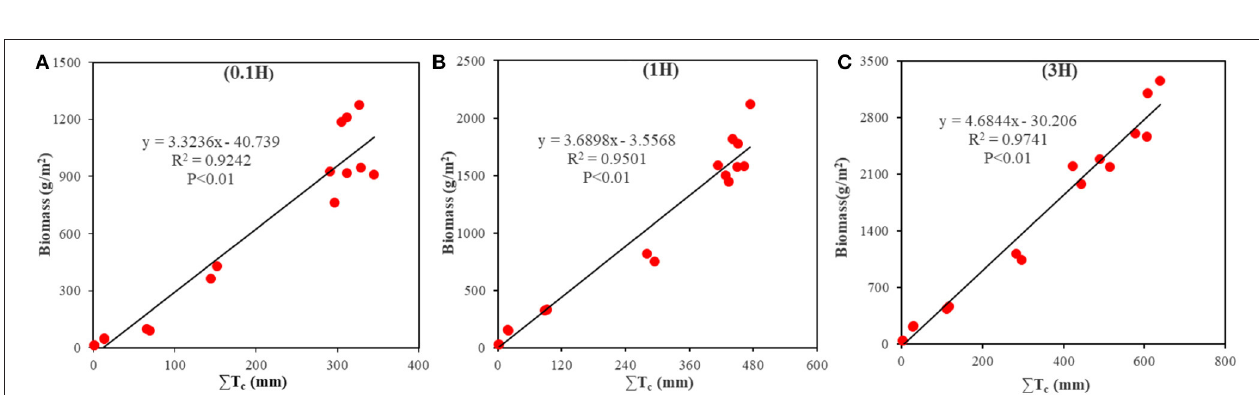
FIGURE 8 | Fitting results of measured biomass and actual transpiration (T c ) at the sampling points with different distances from the shelterbelt (0.1H, 1H, and 3H). (A) represents the fitting result within 0.1H. (B) represents the fitting result within 1H. (C) represents the fitting result within 3H.